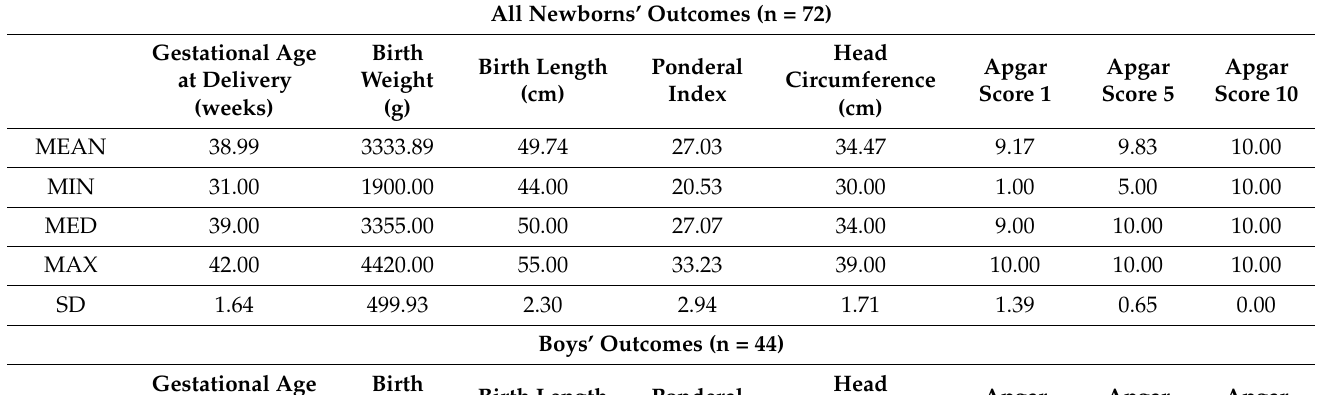
Table 3. Characteristics of newborns’ outcomes. All Newborns’ Outcomes (n =